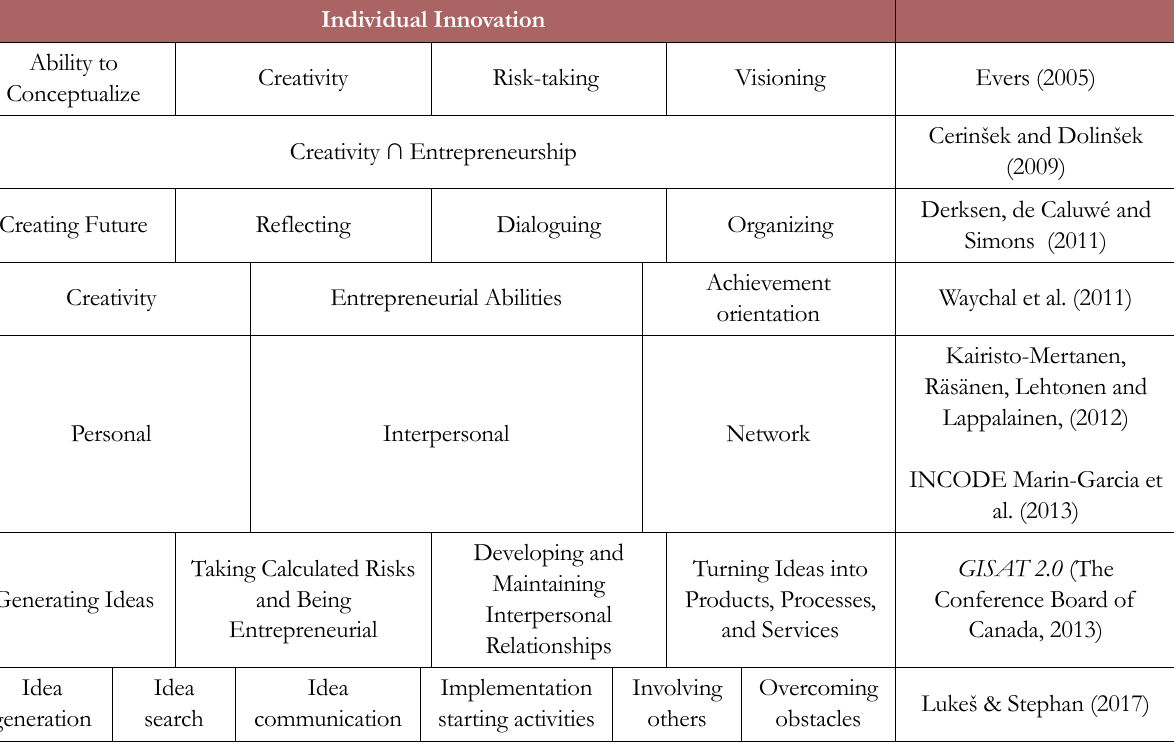
Table 2. Models on Individual